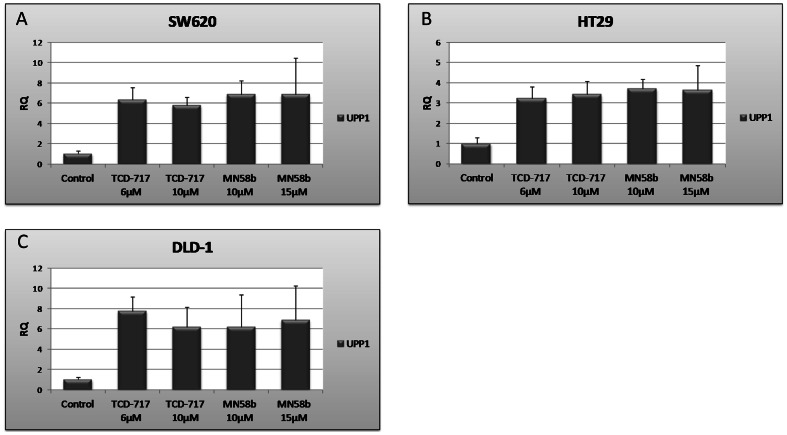

UPP1 mRNA in SW620, HT29 and DLD-1 cell lines.2,5×105 DLD-1, HT29 and SW620 cell lines were seeded in 6 well plates and incubated 24 h under standard conditions. Thereafter, cells were treated with ChoKα inhibitors, TCD-717 (6 and 10 µM) and MN58b (10 and 15 µM) during 24 h. 18S was used as an endogenous control.